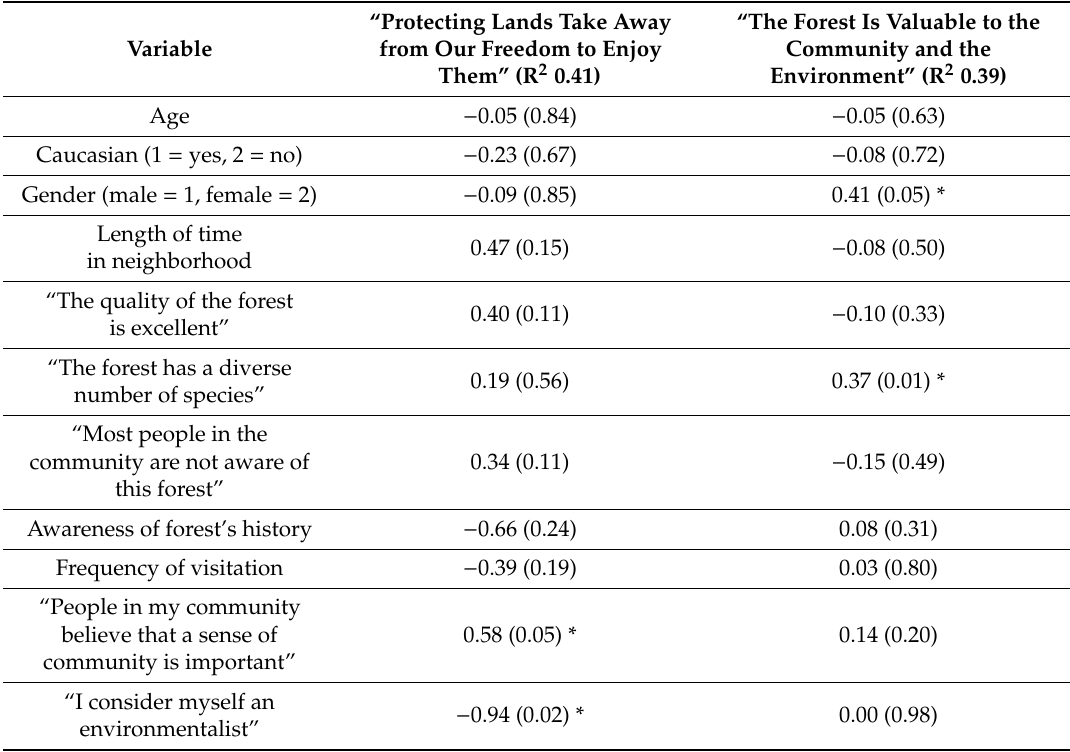
Table 3. Results from the linear mixed models. Beta estimates for each variable, as well as the p -value for each variable (in parentheses), are shown for our model investigating whether people perceived protected status as limiting freedom to use the forest, as well as for our model investigating how people perceived the value of the forest. Significant beta values are marked with *. R 2 for each model is displayed in parentheses after the question the model investigated as a dependent variable. “The Forest Is Valuable to the “Protecting Lands Take Away Community and the Variable from Our Freedom to Enjoy Environment” (R 2 0.39) Them” (R 2 0.41) Age − 0.05 (0.84) − 0.05 (0.63) − 0.23